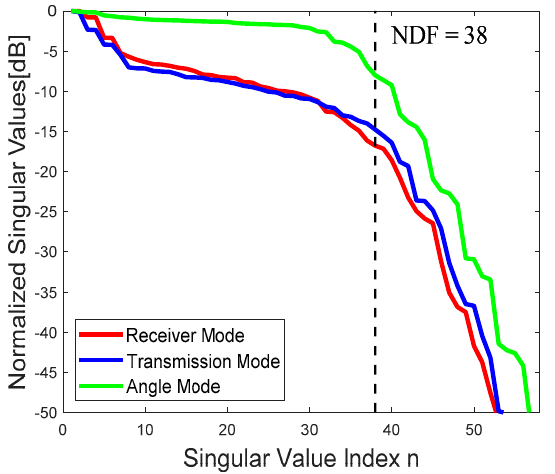
Figure 8. Comparison of the behavior of the normalized singular values of the reflection mode (red line), transmission mode (blue line), and angle mode (green line). line), transmission mode (blue line), and angle mode (green line).